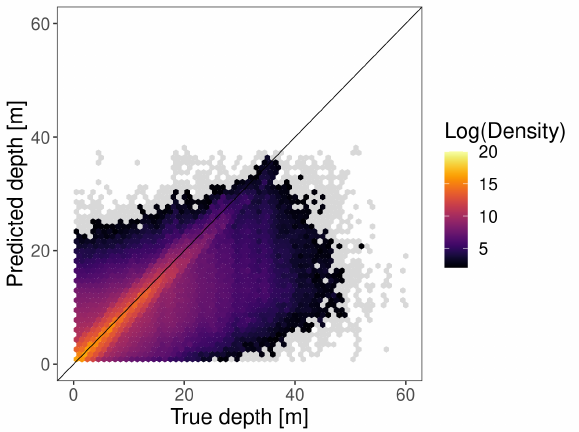
Figure 5. Ground-truth depth versus predicted depth computed on all images from our test set. The yellow and orange areas indicate points with high density, whereas the purple and black areas show points with low density. The gray areas represent areas with very low density (a few depth points). The most densely populated areas lie along the 1:1 line. Often, our model tends to underestimate the depth of distant